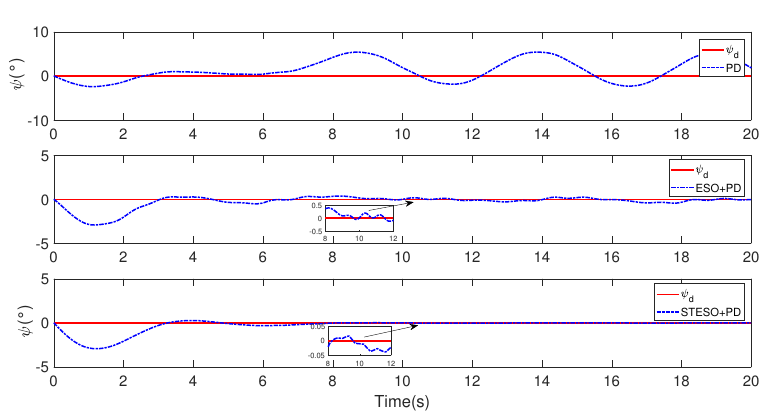
Figure 5. Simulation curves of ψ in Case